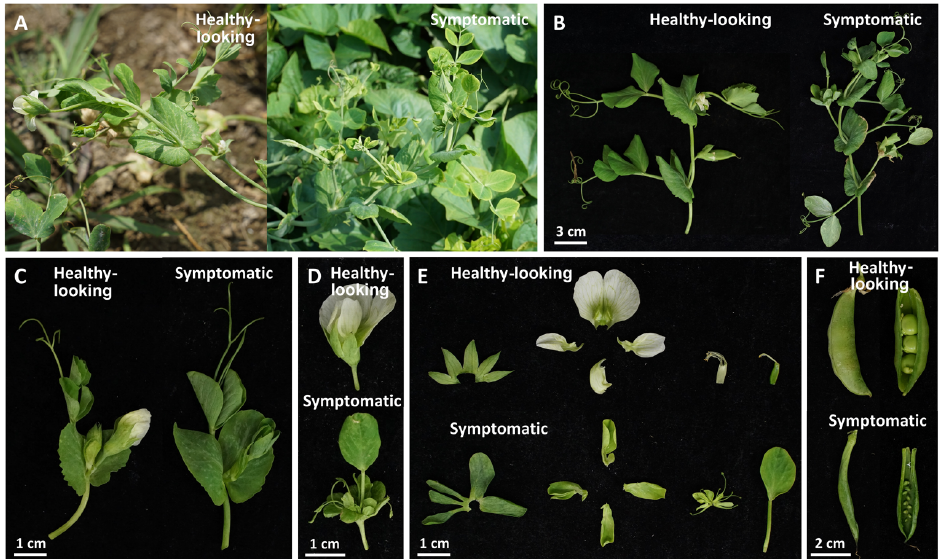
Figure 1. Comparison of the phenotype of symptomatic and healthy-looking green peas. ( A ) The healthy-looking and symptomatic plants found in the field of green peas in Mailiao, Yunlin, Taiwan. ( B ) The shoot proliferation with varying severity from floral organ symptoms observed in sympto- matic peas. ( C ) A flower with phyllody and virescence symptoms in the symptomatic green pea (right) compared to the healthy-looking one (left). ( D ) Close-up view of flared flowers in the healthy-looking green pea (above), and green leaf-like flowers in the symptomatic green pea (be- low). ( E ) An anatomical diagram of healthy-looking (above) and symptomatic (below) floral organs showing sepal, petal, stamen and carpel from left to right. ( F ) A significant reduction in the seed development of the symptomatic green pea compared to the healthy-looking one of the cultivated pea variety. In the August of 2021, parthenium weeds displaying outward phytoplasma disease symptoms were also discovered in Mailiao, Yunlin County, Taiwan (Figure 2A). The inci- dence rate in the sampling area was about 11% (4 were symptomatic and 31 were healthy- looking). Infected samples lose general flower characteristics, and the branches have dra- matically proliferated (Figure 2B,C). Closer observation of the flower samples of infected ones revealed definite virescence and phyllody symptoms.